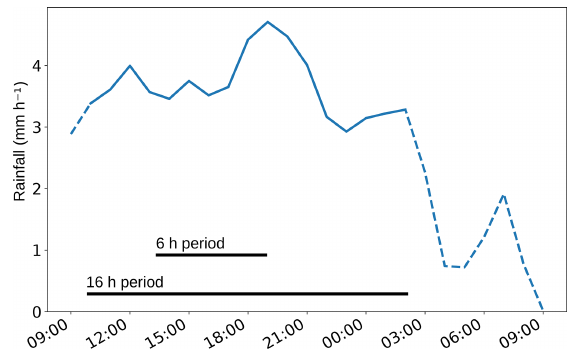
Figure 3. Hourly rainfall integrated over LAKEDISTR, starting on 5 December 2015, 10:00UTC. The solid blue line indicates the 16h period used to calculate the totals in Sect. 4. Solid black lines: time periods used to average